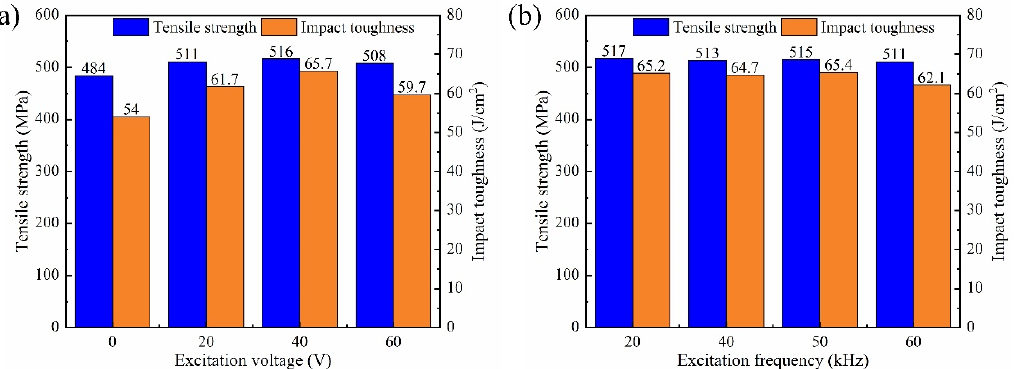
Figure 15. The average tensile strength and impact toughness of welded joints: ( a ) different ultra ‐ sonic excitation voltages at 30 kHz; ( b ) different ultrasonic excitation pulse frequencies at 40 V.